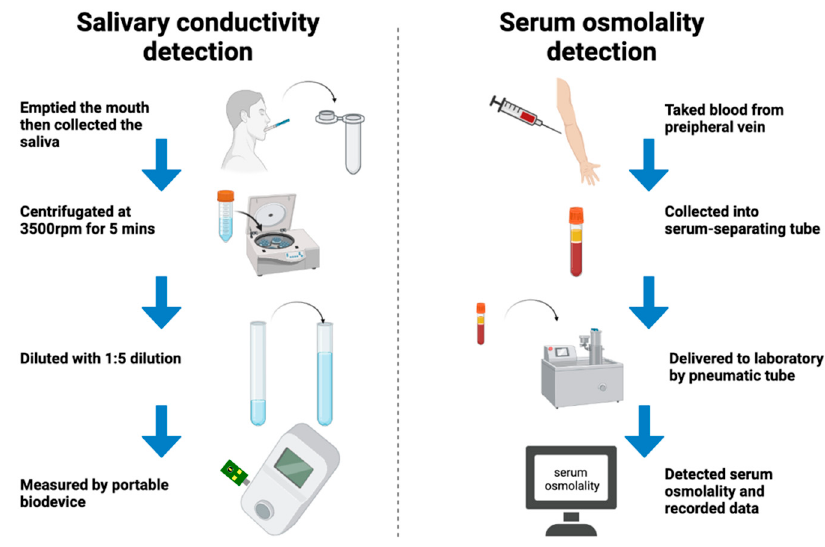
Figure 2. Protocol of the detection of salivary conductivity and serum osmolality.